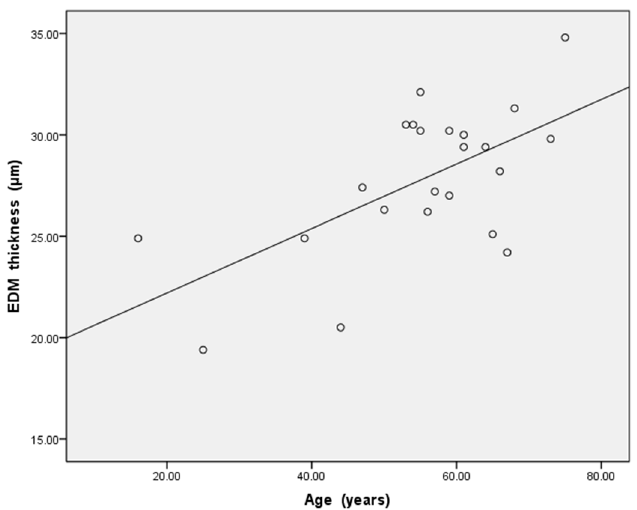
Figure 4. In all 23 subjects of Group1, the thickness of the EDM tended to become thicker with age. There was a highly significant positive correlation (r = 0.619, p < 0.05) between the EDM thickness and age.